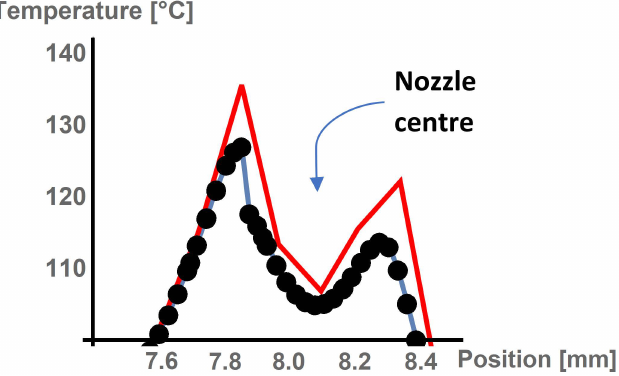
Figure 3. Mesh convergence evaluation under the nozzle. Black—extremely fine Mesh; blue—fine mesh; red—coarse mesh.